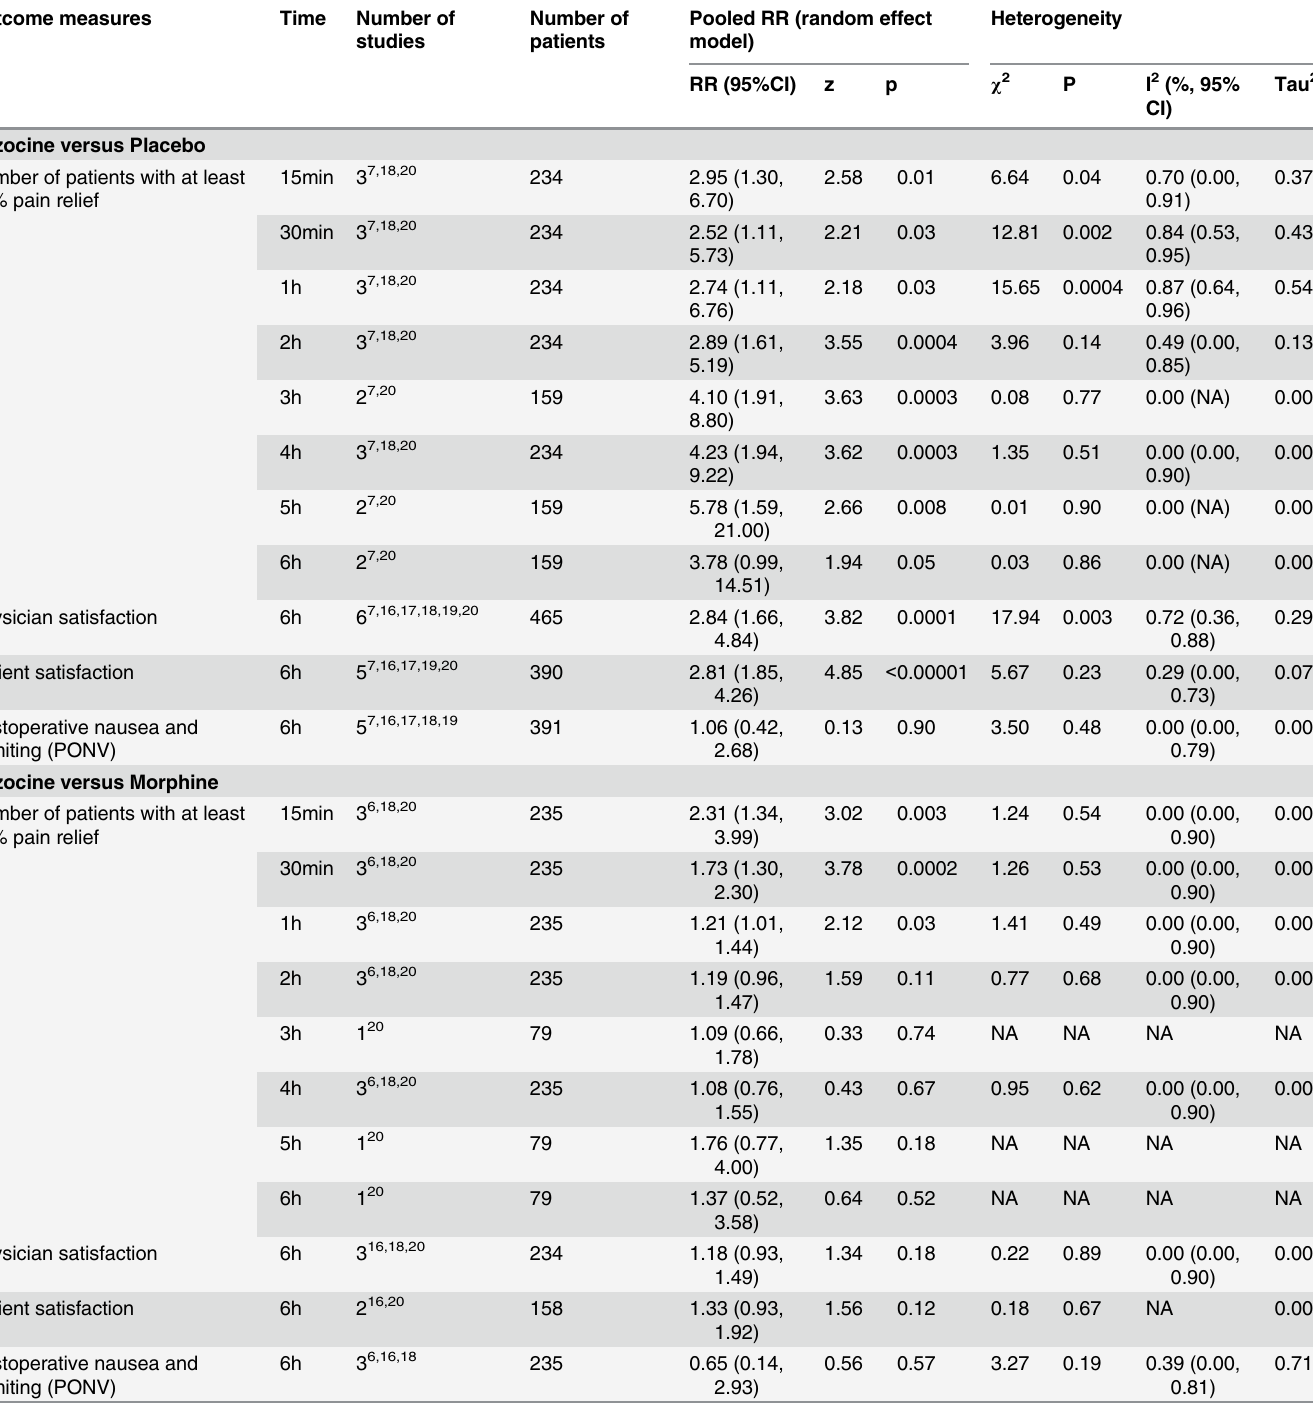
Table 3. Summary of